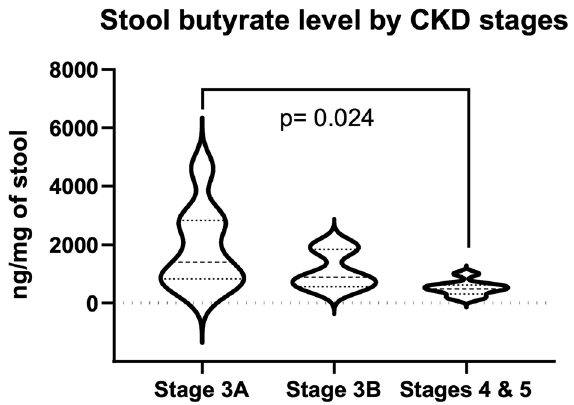
Figure 7. Stool butyrate level in CKD patients. Overall p-value was calculated using one-way ANOVA (p-value = 0.0240). Adjusted p-value was calculated using Tukey’s multiple comparison test (Stage 3A vs. Stage 3B adjusted p-value = 0.2962; Stage 3A vs. Stage 4 and 5 adjusted p-value = 0.0216; Stage 3B vs. Stage 4 and 5 adjusted p-value =